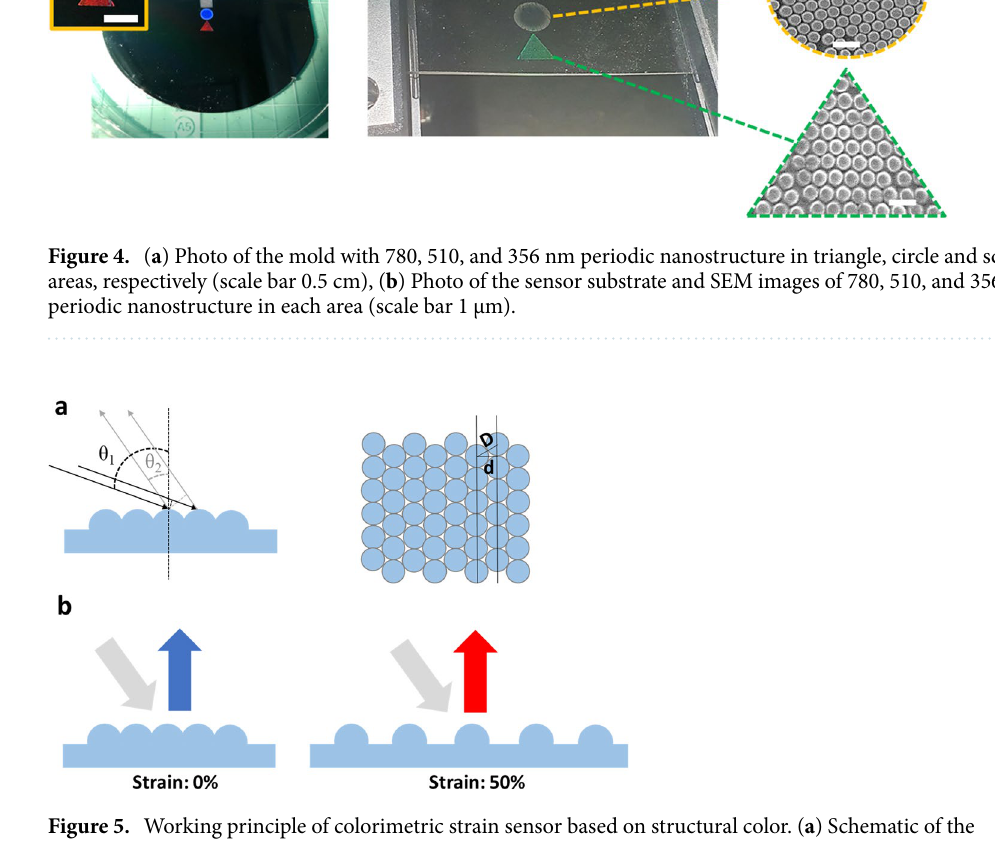
Figure 5. Working principle of colorimetric strain sensor based on structural color. ( a ) Schematic of the diffraction phenomenon with 2D hexagonal photonic crystal structure. ( b ) Incident light and diffracted light out of the sensor at initial (0% strain) and at stretched (50% strain)